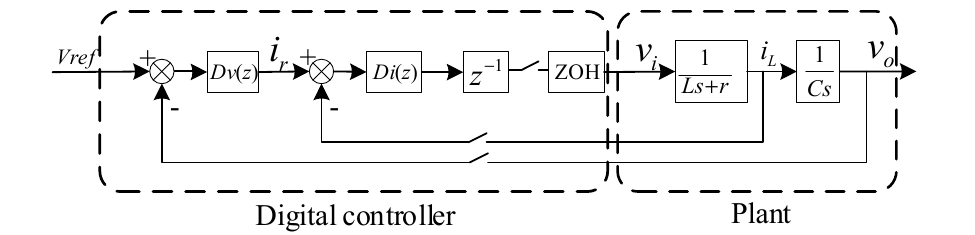
Figure 2. Multi-loop inverter control structure.